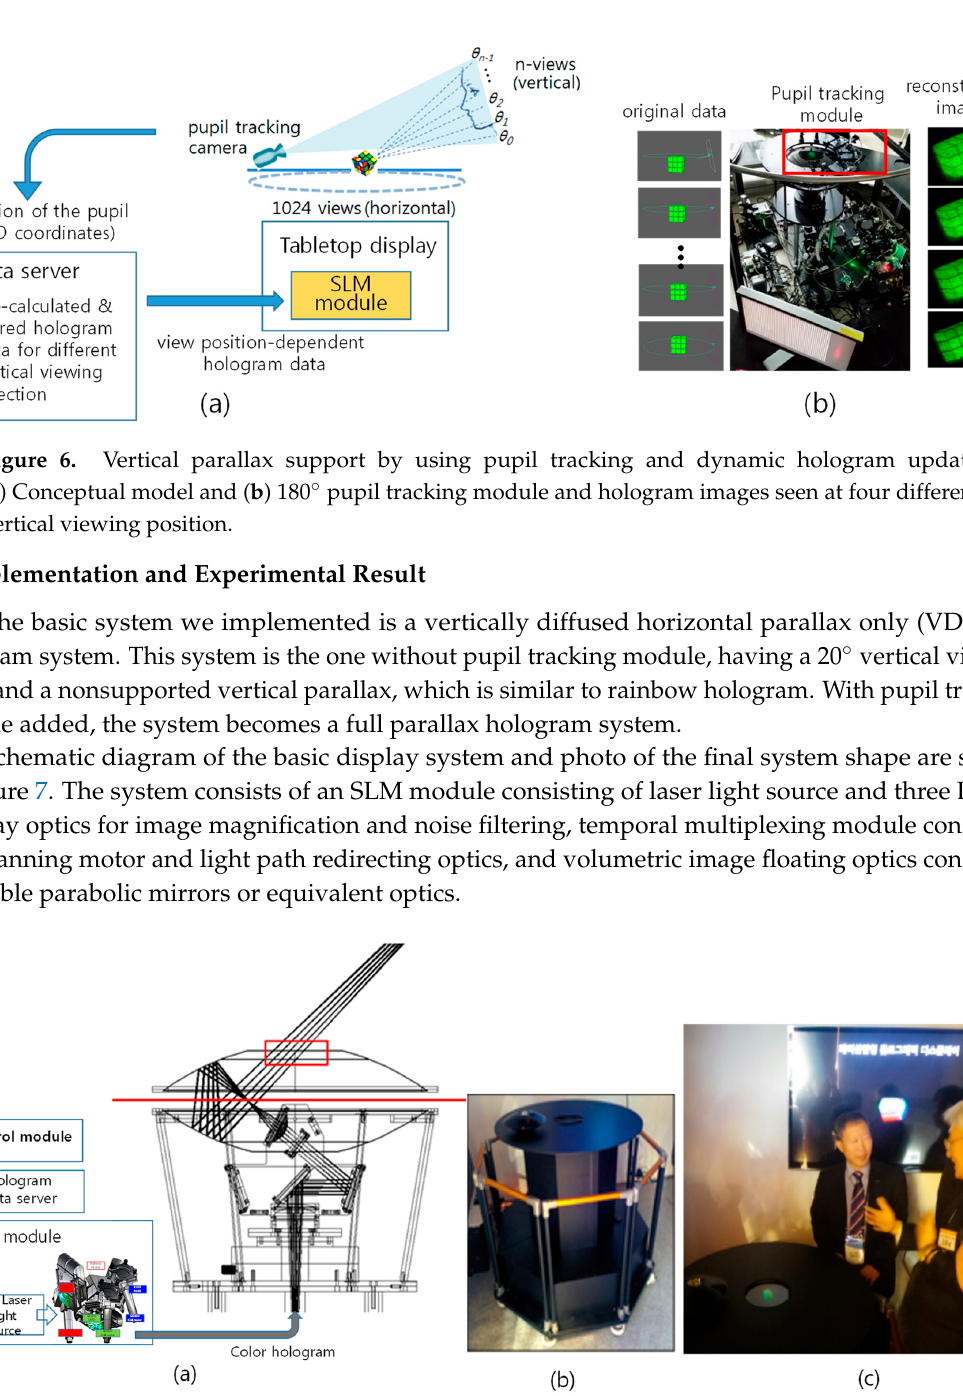
Figure 7. ( a ) Schematic configuration. ( b ) Photo of the implemented system. ( c ) Demonstration.